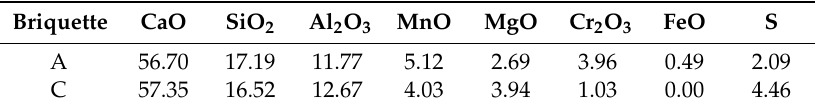
Table 3. Average compositions (SEM-EDS analysis) of the slags obtained from di ff erent briquettes after completion of the TGR experiments (in